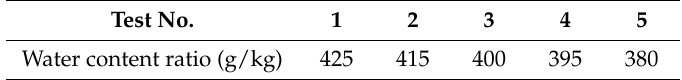
Table 6. The testing results of the water content ratio of the saturated solid desiccant module. Test